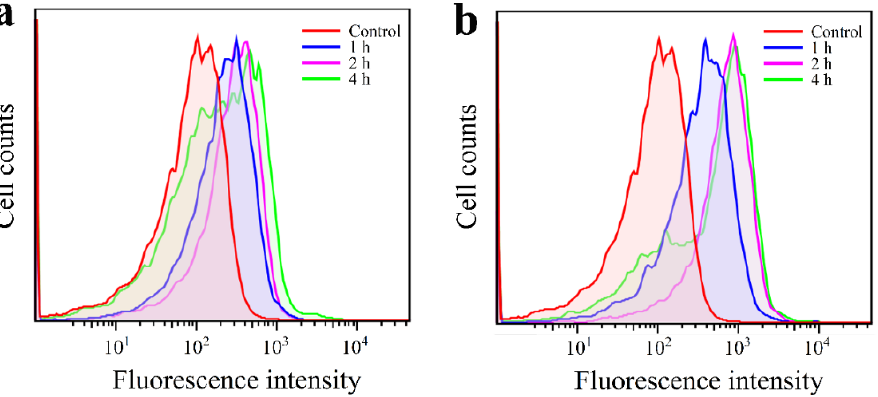
Figure 11. FCM analysis of HepG2 cells after incubation with HAg 2 S@HMPDA/PEI ( a ) and HAg 2 S@HMPDA/LA ( b ).